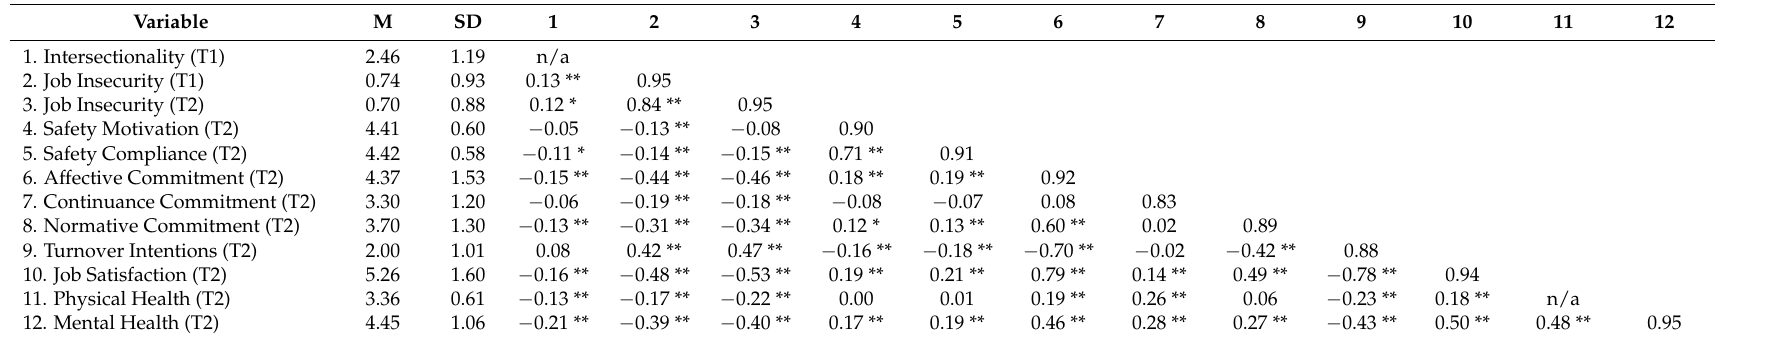
Table 1. Descriptive statistics and